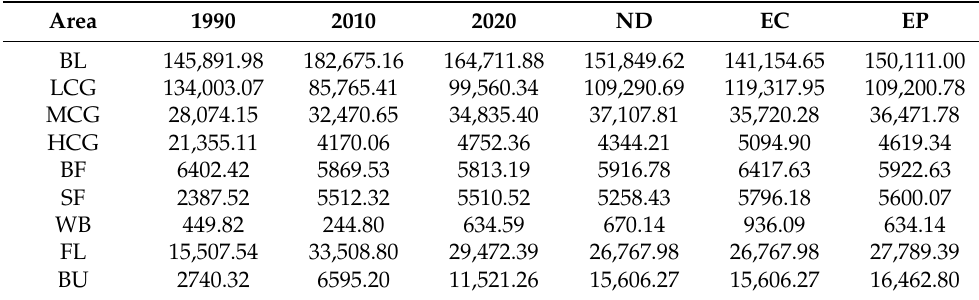
Figure 3. Land use change from 1990 to 2030 under the different scenarios. Table 2. The Area of different land types in Dunhuang Oasis from 1990–2030 (hm 2 ). Area 1990